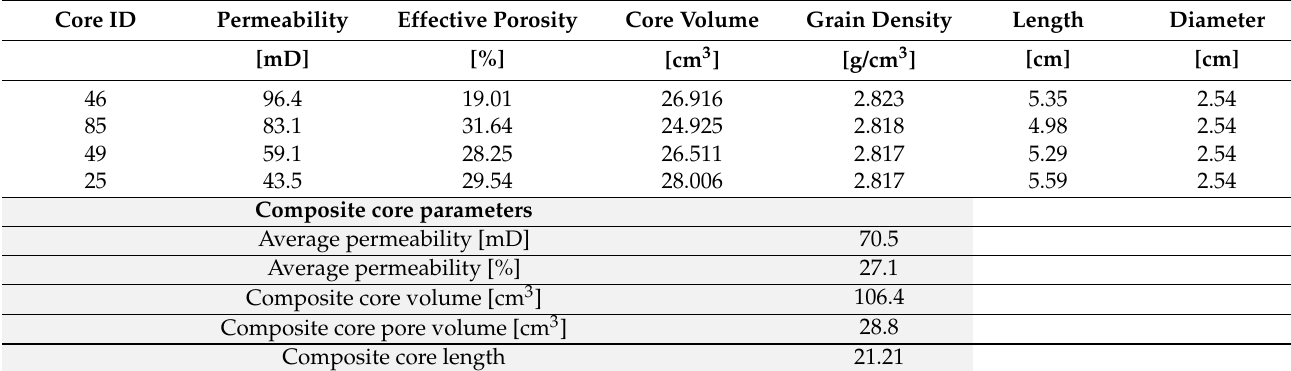
Table 5. Individual core parameters of composite core no 1.